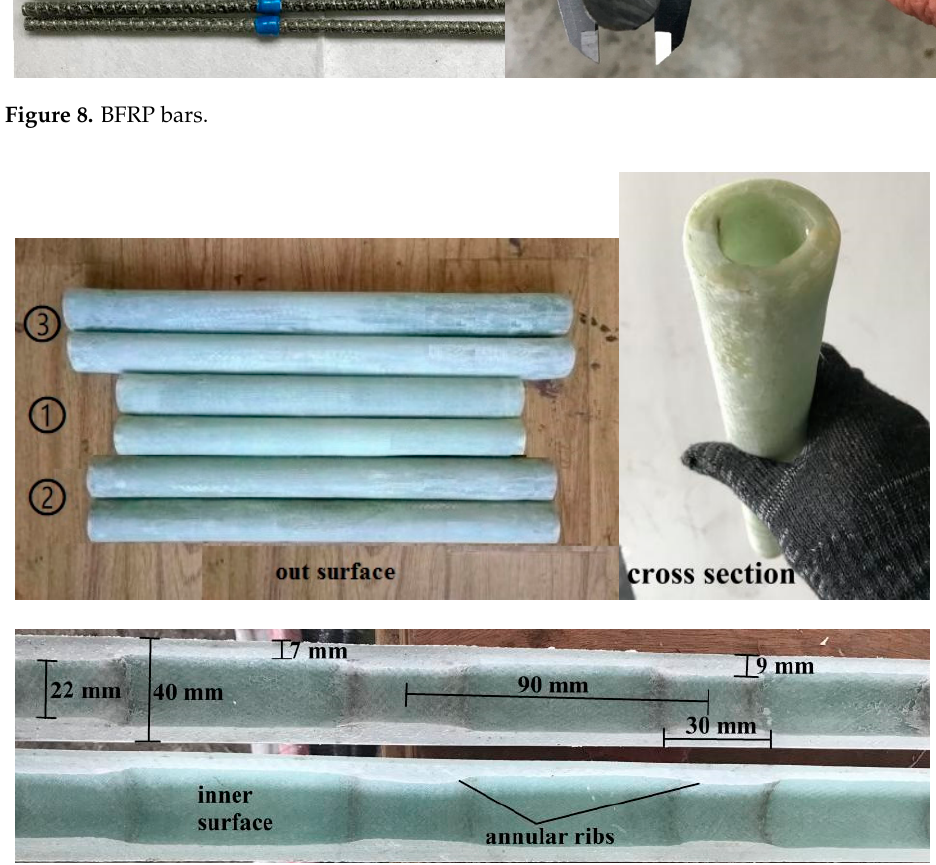
Figure 9. The designed GFRP pipe. Table 1. Material properties.